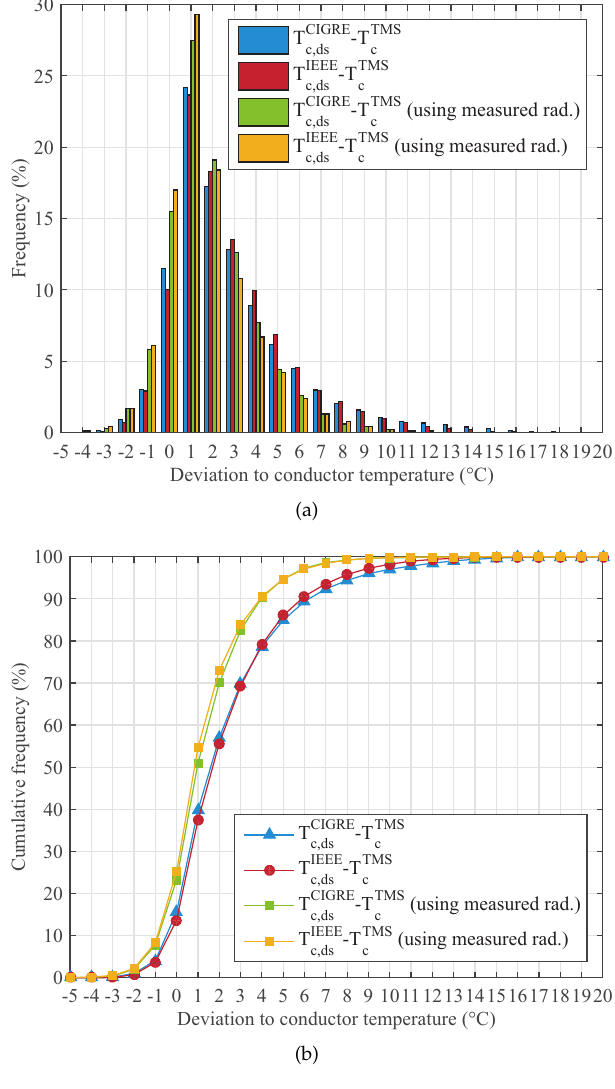
Figure 5. Frequency and cumulative frequency of differences between temperatures obtained using CIGRE ( T CIGRE ) and IEEE ( T IEEE ) standards and T TMS c for an entire year, with estimated and c , ds c , ds measured radiation. ( a ) Frequency; ( b ) Cumulative